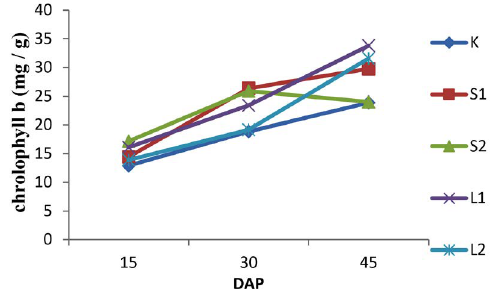
Fig. 5. Induced compost effect on chlorophyll b content. K = control; S1 = Cellulolytic (10%); S2=Cellulolytic (20%); L1 = Ligninolytic (10%); L2 = Ligninolytic (20%).